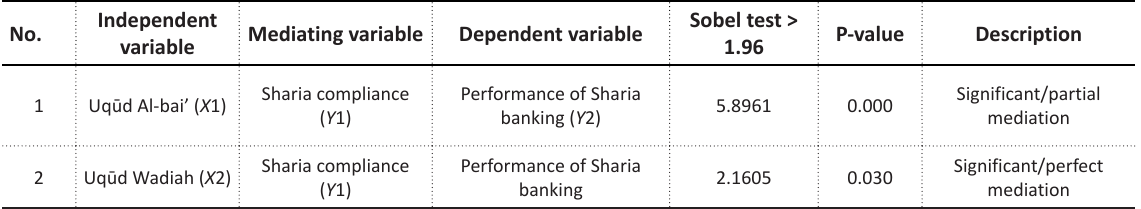
Table 3. Test results on the mediating variable: the coefficient of indirect influence with the Sobel test